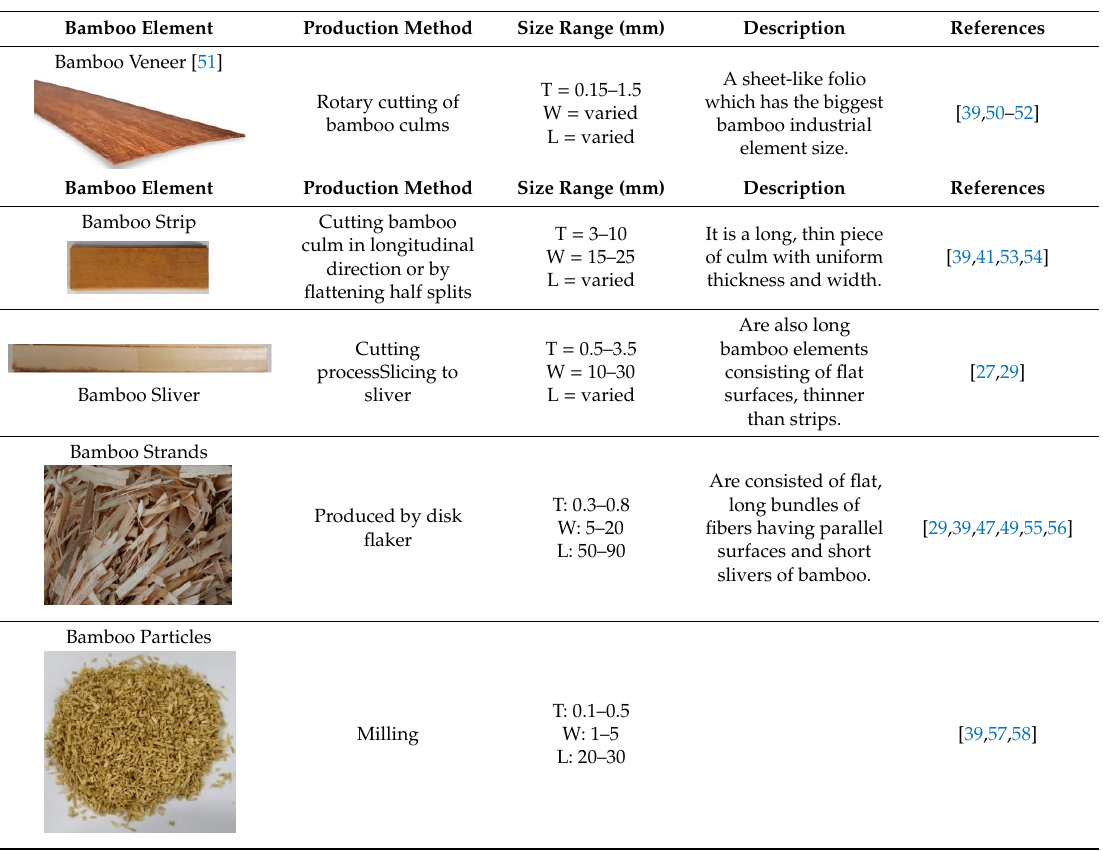
Table 1. The classification of bamboo elements used in densified products (specifically bamboo based panels